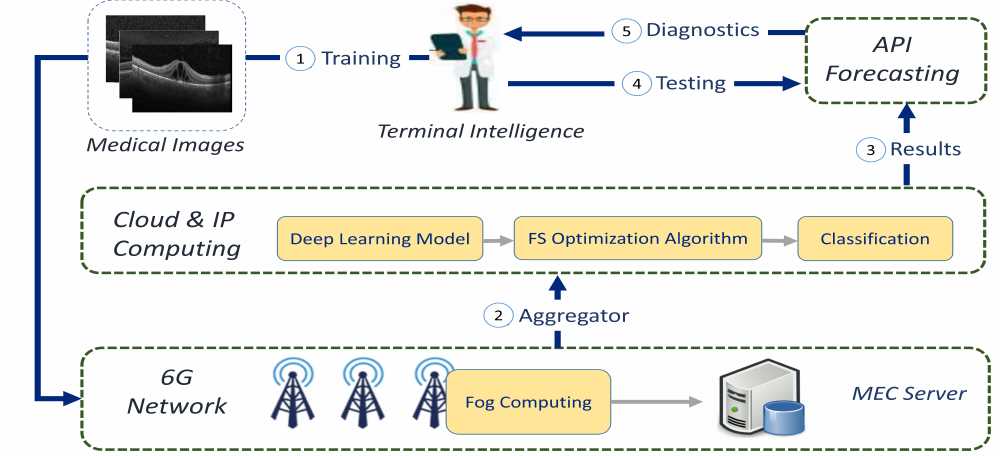
Figure 2. The suggested 6G-enabled IoMT framework